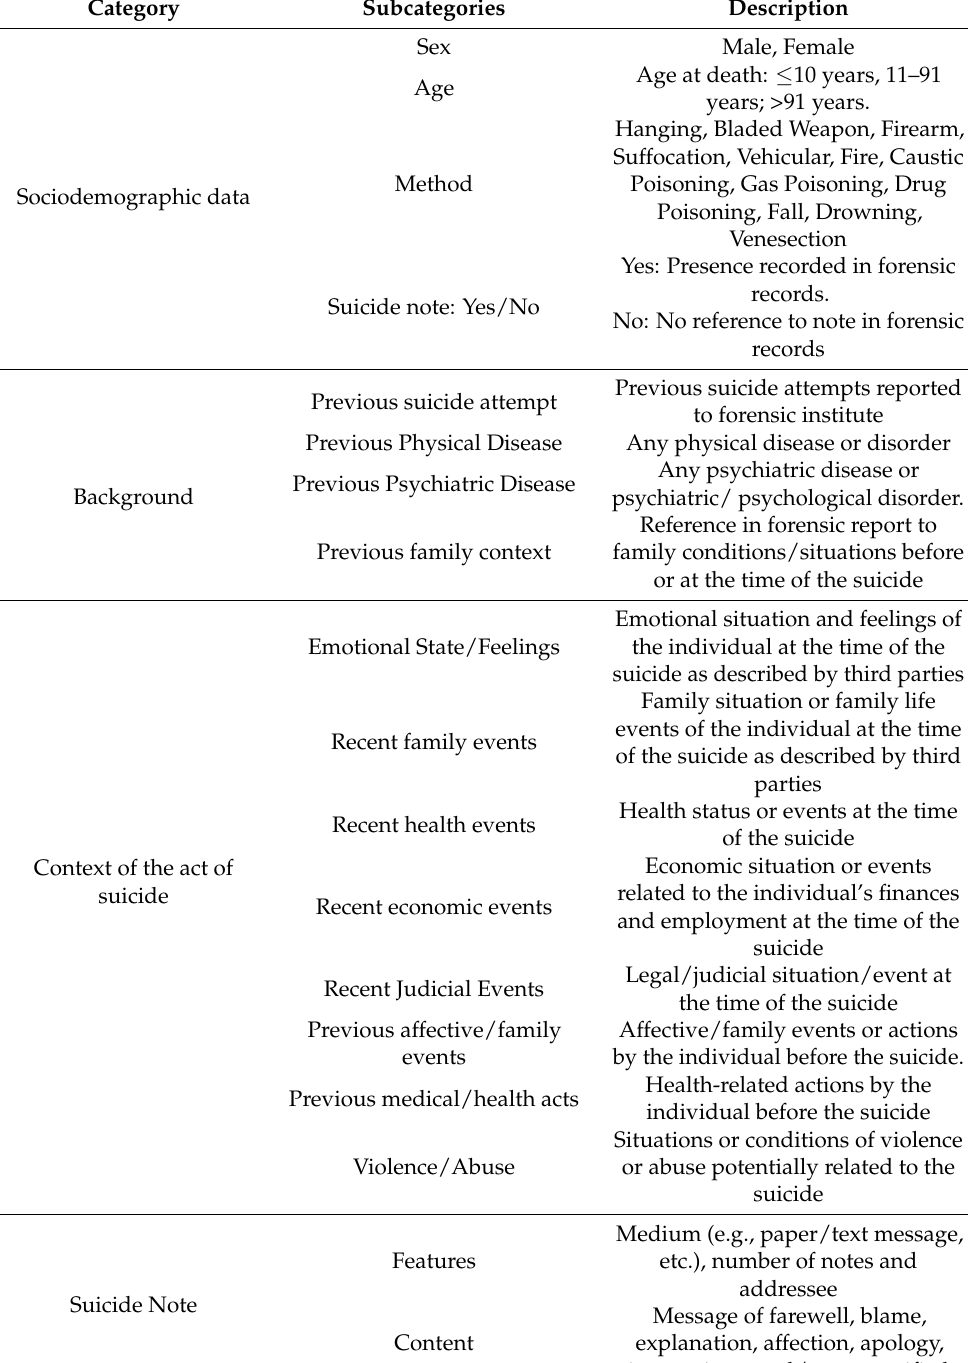
Table 2. Categories and subcategories in content